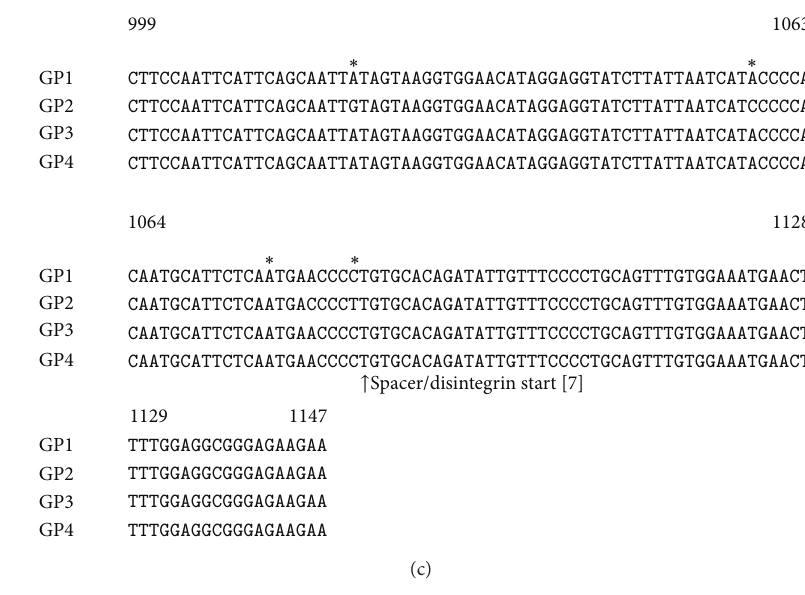
Figure 1: Alignment of the four groups (GP1, GP2, GP3, and GP4) of C. s. scutulatus metalloproteinase genomic DNA sequences. Assignment of exon and intron (underlined) regions was made by comparing metalloproteinase cDNA sequences from C. atrox [7] and A. contortrix [12, 30] with metalloproteinase genomic DNA sequences from C. s. scutulatus obtained in this study. Differences among the DNA sequences are denoted by an asterisk ( ∗ ).